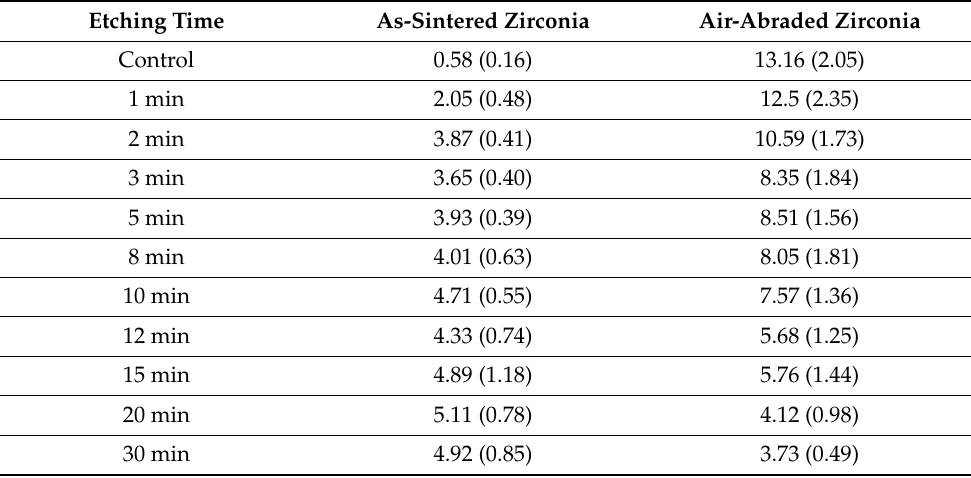
Table 2. Monoclinic phase contents of the as-sintered and air-abraded zirconia samples in accordance with etching time. In as-sinter zirconia, the value slightly increased as the etching time increased, and